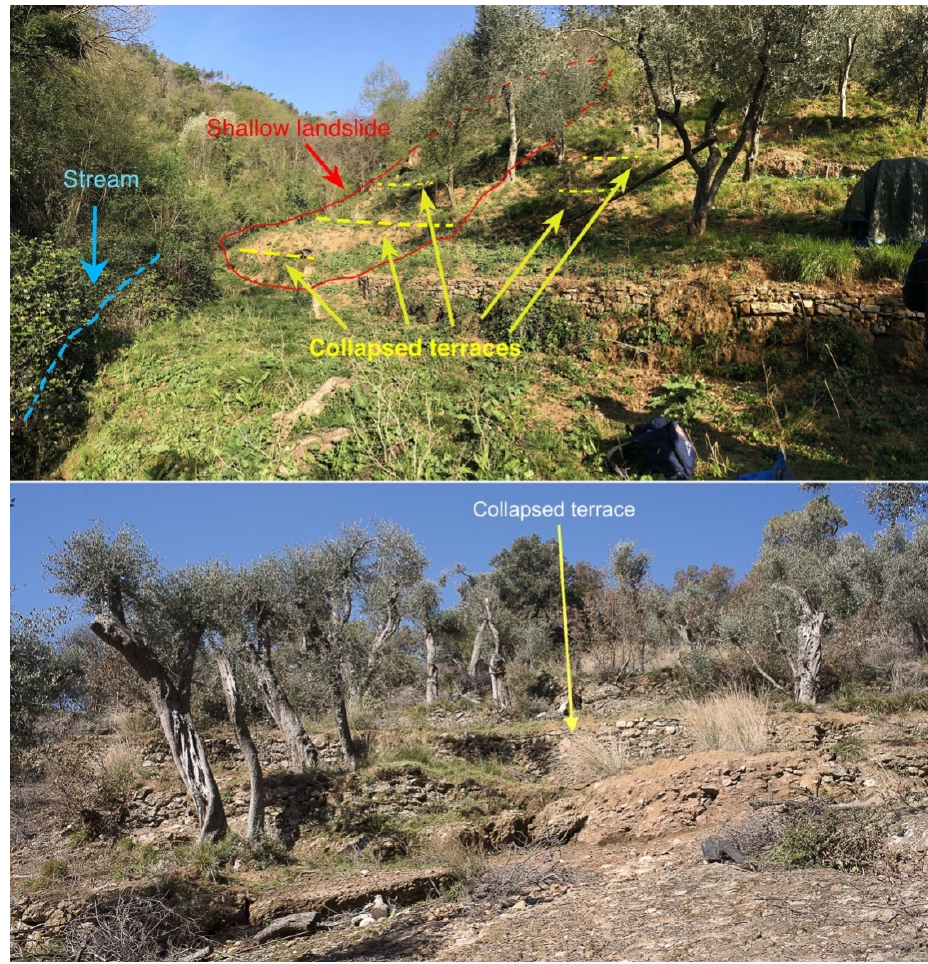
Figure 8. Examples of partially collapsed terraces: up, in the medium catchment n. 5 and down, on conglomerate substratum in the catchment n. 3.